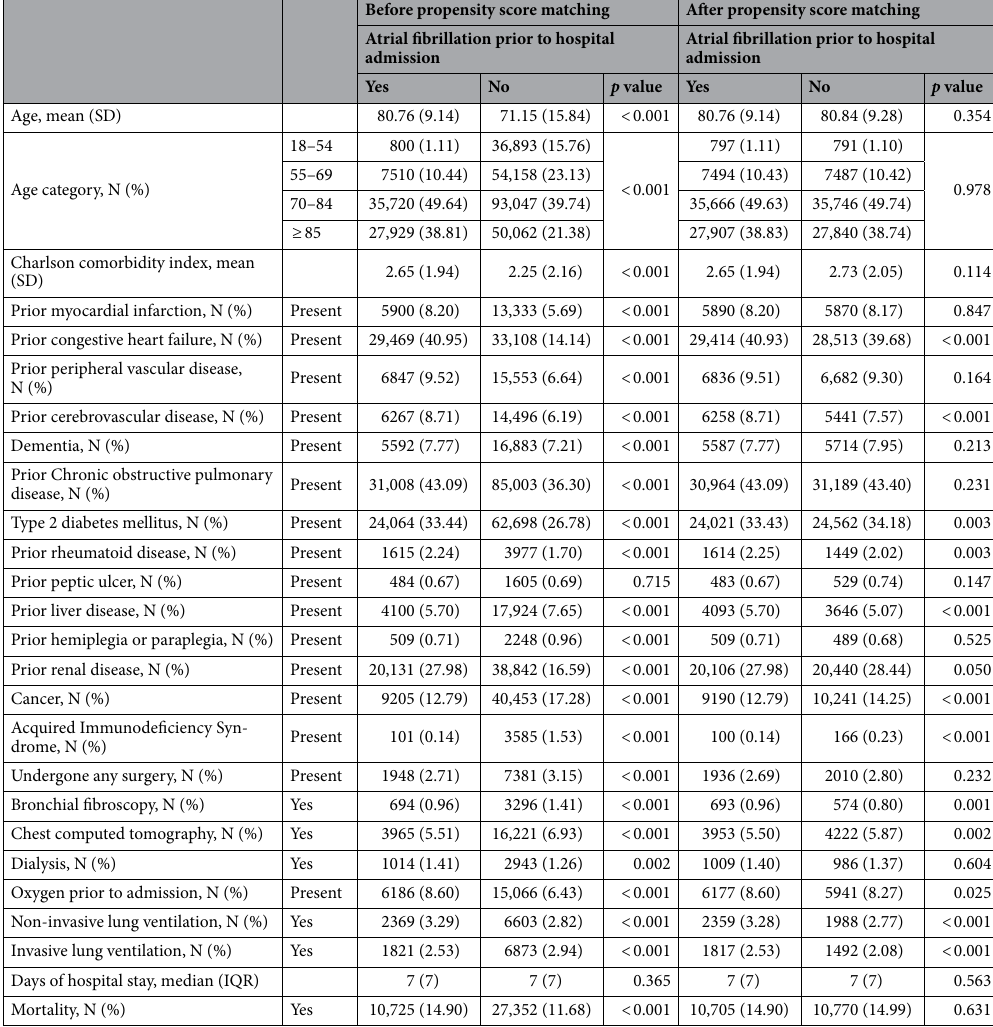
Table 3. Clinical characteristics, and in-hospital outcomes of men hospitalized with community-acquired pneumonia in Spain from 2016 to 2019 according to atrial fibrillation prior to hospital admission, before and after propensity score